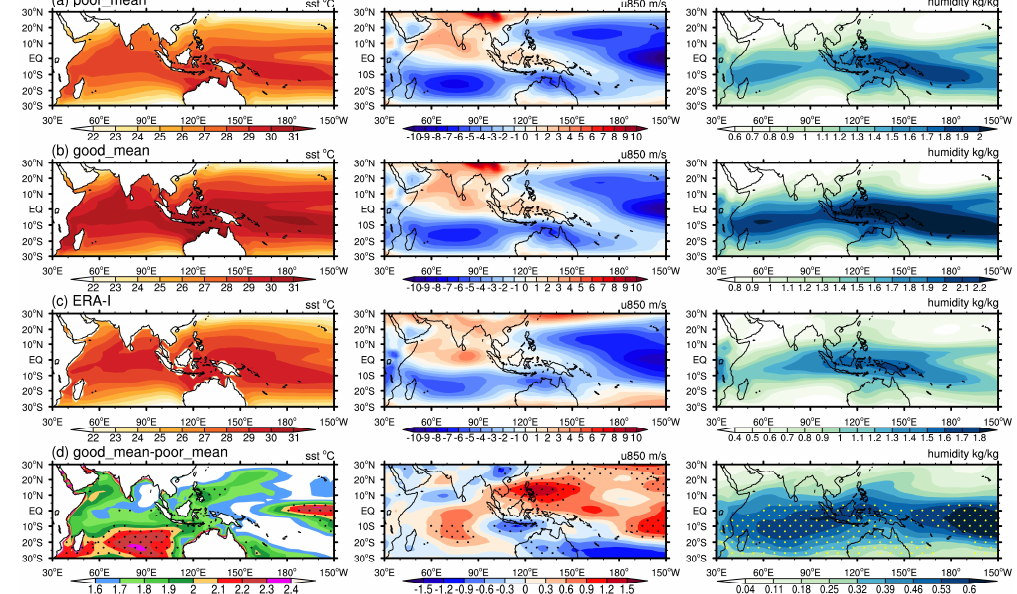
Figure 10. Boreal winter (November–April) mean state of Sea Surface Temperature (SST, left column), 850 hPa zonal wind (u850, middle column) and integrated low-level (850–500 hPa) specific humidity in ( a ) composite of poor simulations, ( b ) composite of good simulations, ( c ) observations and ( d ) the differences between composites of good and poor composites. The differences reaching 90% confidence level are dotted in ( d ).